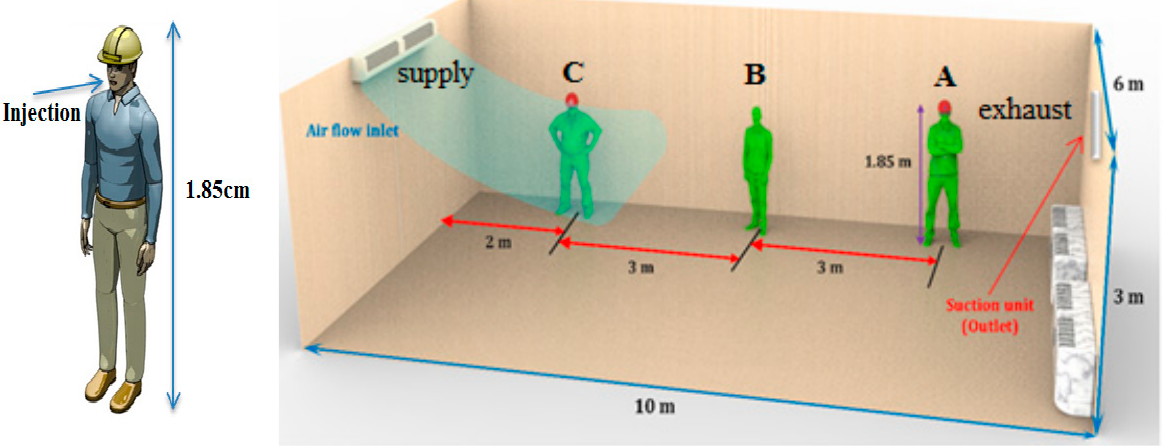
Figure 1. Geometry of the ventilation air flow pattern and mannequins in the indoor space (Case 1).